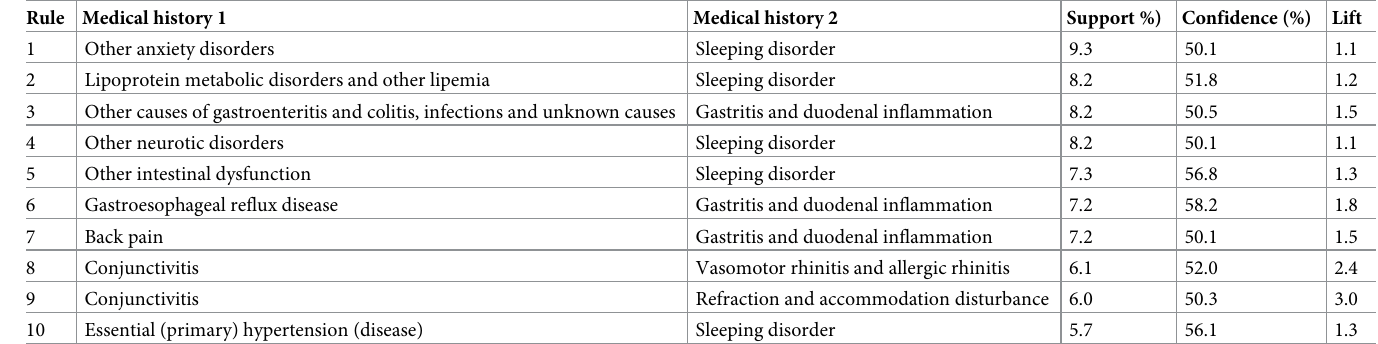
Table 1. Association rules for medical histories before the onset of depression.